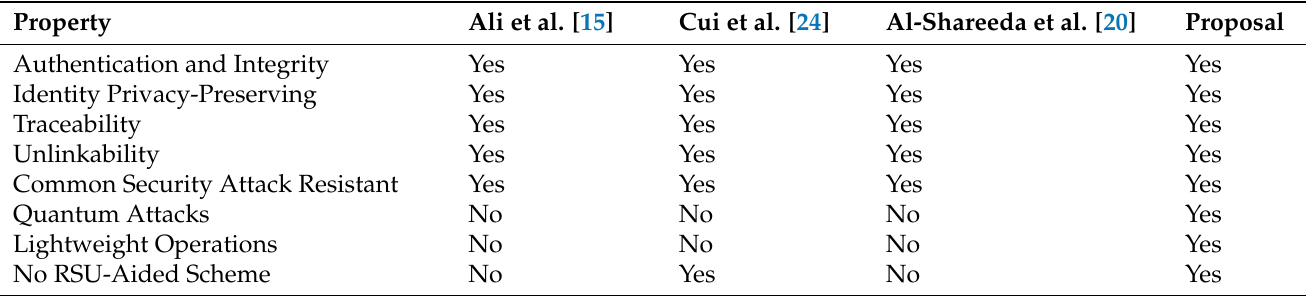
Table 1. Comparison of relevant works’ properties of privacy and